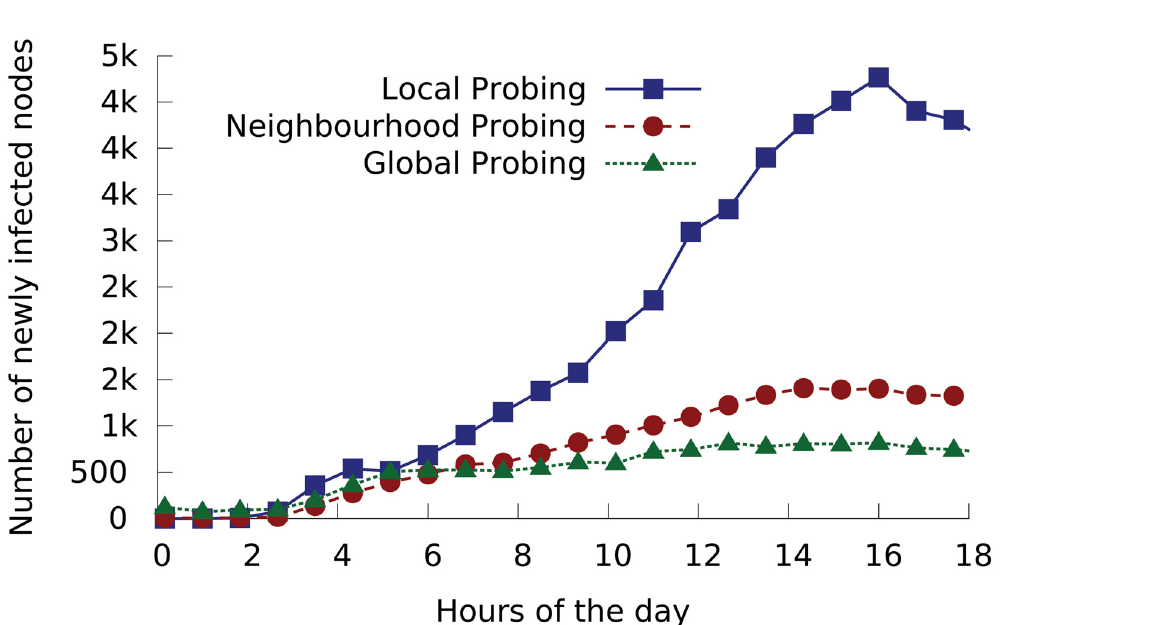
Fig 4. Numbers of nodes newly infected by Conficker via each of the three spreading mechanisms in 10-minute windows on the day of Conficker ’ s outbreak, as inferred from CAIDA ’ s dataset on 21/Nov/2008.